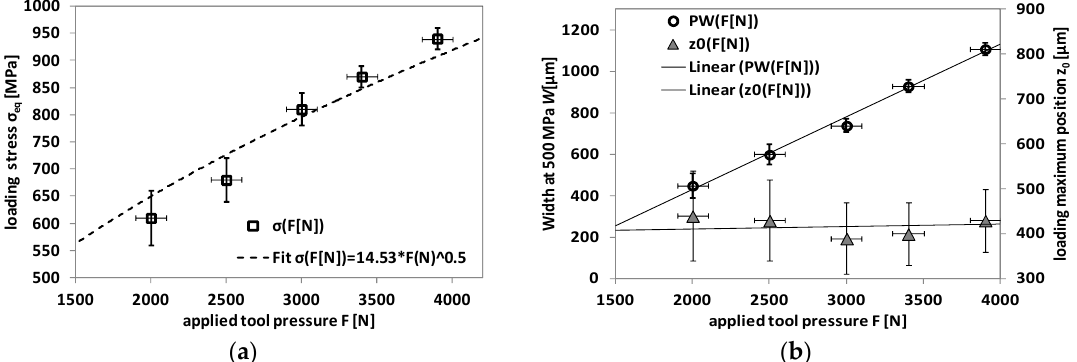
Figure 5. ( a ) Equivalent stress maximum over applied force F[N] and ( b ) width of fit function over applied force F[N] for internal equivalent stresses during loading.